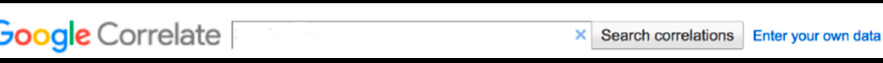
Figure 1. Screenshot of Google Correlate input page.